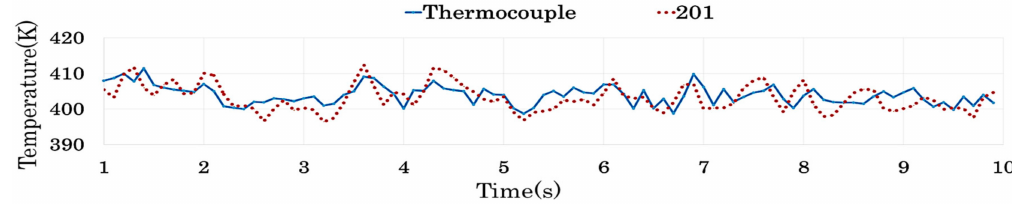
Figure 11. Comparison of T Thc and T Rec for 201